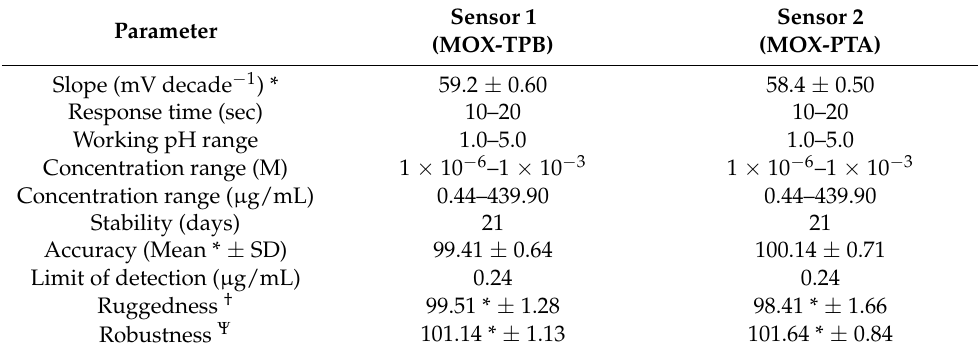
Table 1. Electrochemical response characteristics of the fabricated